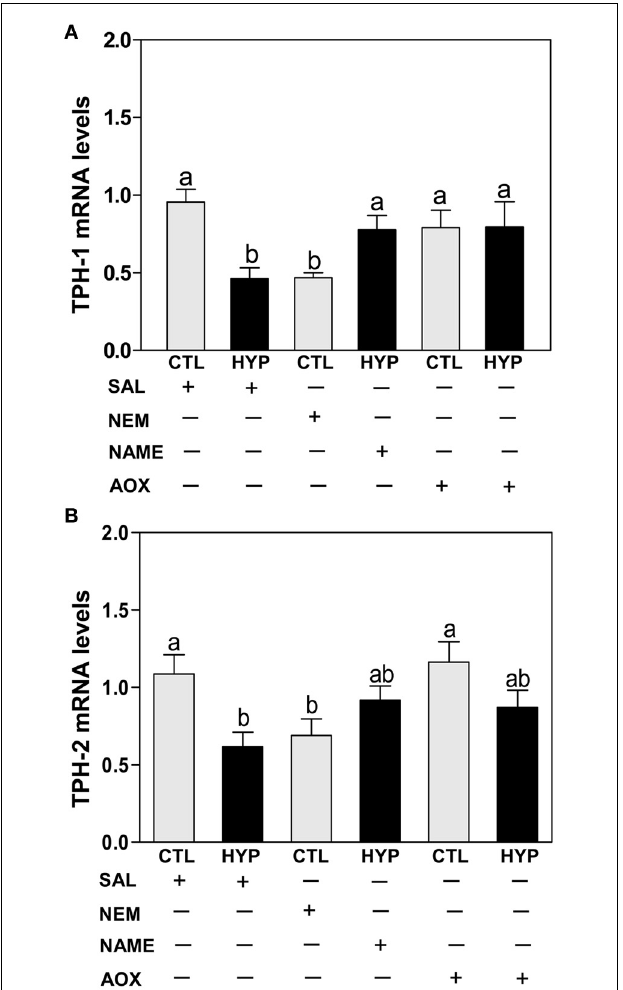
FIGURE 3 | Interactive effects of hypoxia and pharmacological agents that modulate generation of ROS and RNS on TPHs mRNA expression determined by quantitative real-time PCR in croaker hypothalamus. Effects of hypoxia (DO: 1.7mg/L for 4 weeks) exposure and pharmacological treatments with NEM, NAME, and AOX on expression of TPH-1 (A) and TPH-2 (B) mRNA levels in croaker hypothalamus. Each bar represents mean ± s.e.m. ( N = 9–12, results from both sexes were combined because they were not significantly different). Fisher’s PLSD, are indicated with different letters ( P < 0 . 05). SAL, saline; CTL, control; HYP,